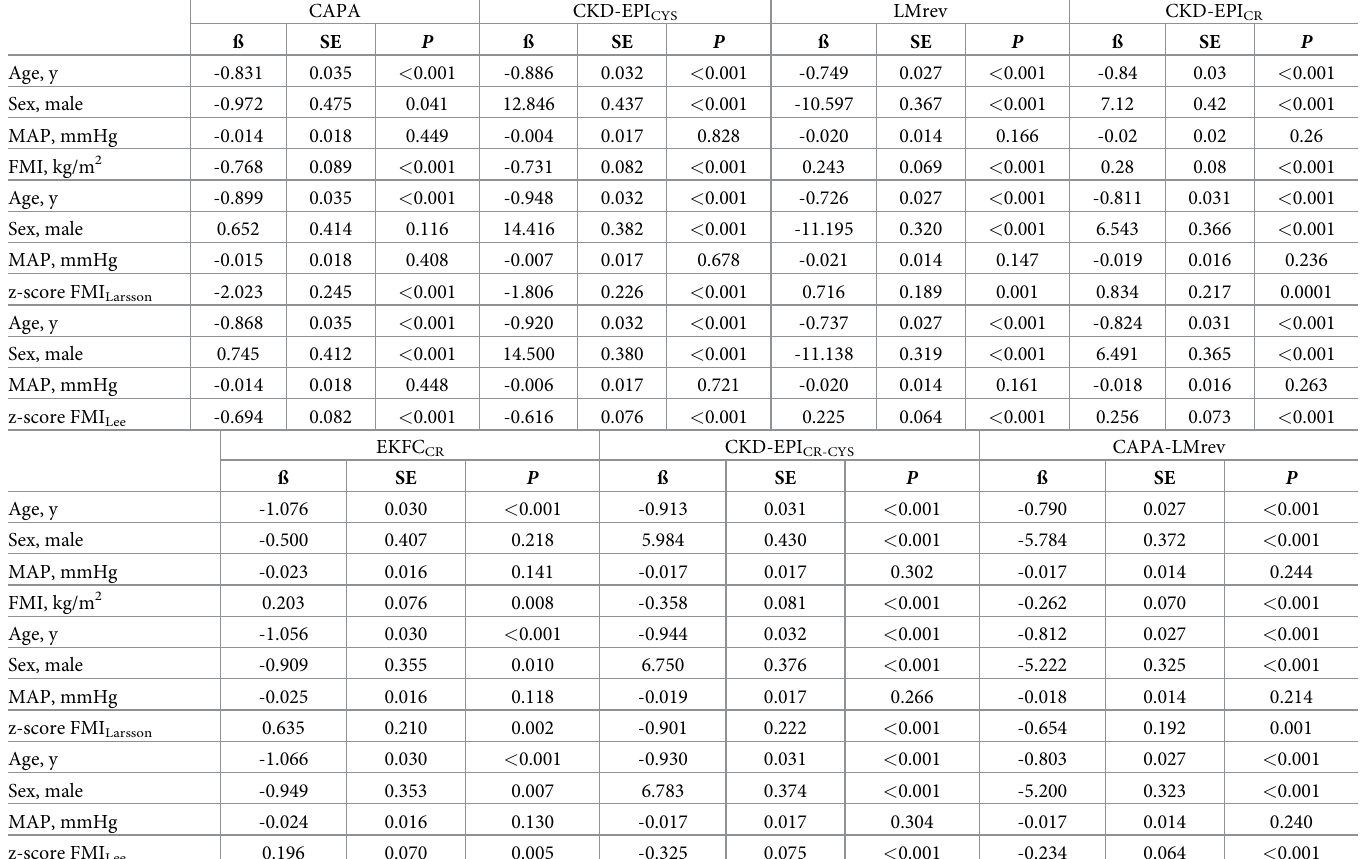
Table 4. Association between fat mass index z-scores and eGFR